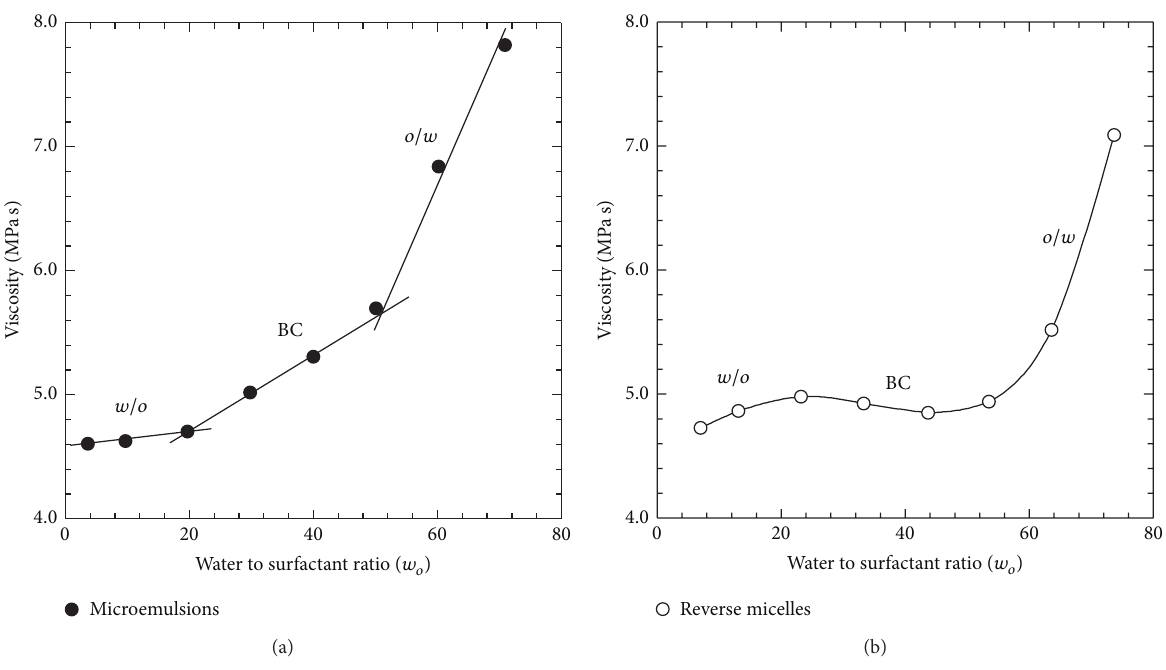
Figure 4: Viscosities as a function of 𝑤 𝑜 for (a) CTAB/1-butanol/cyclohexane/water microemulsions and (b) CTAB/1-butanol/water reverse